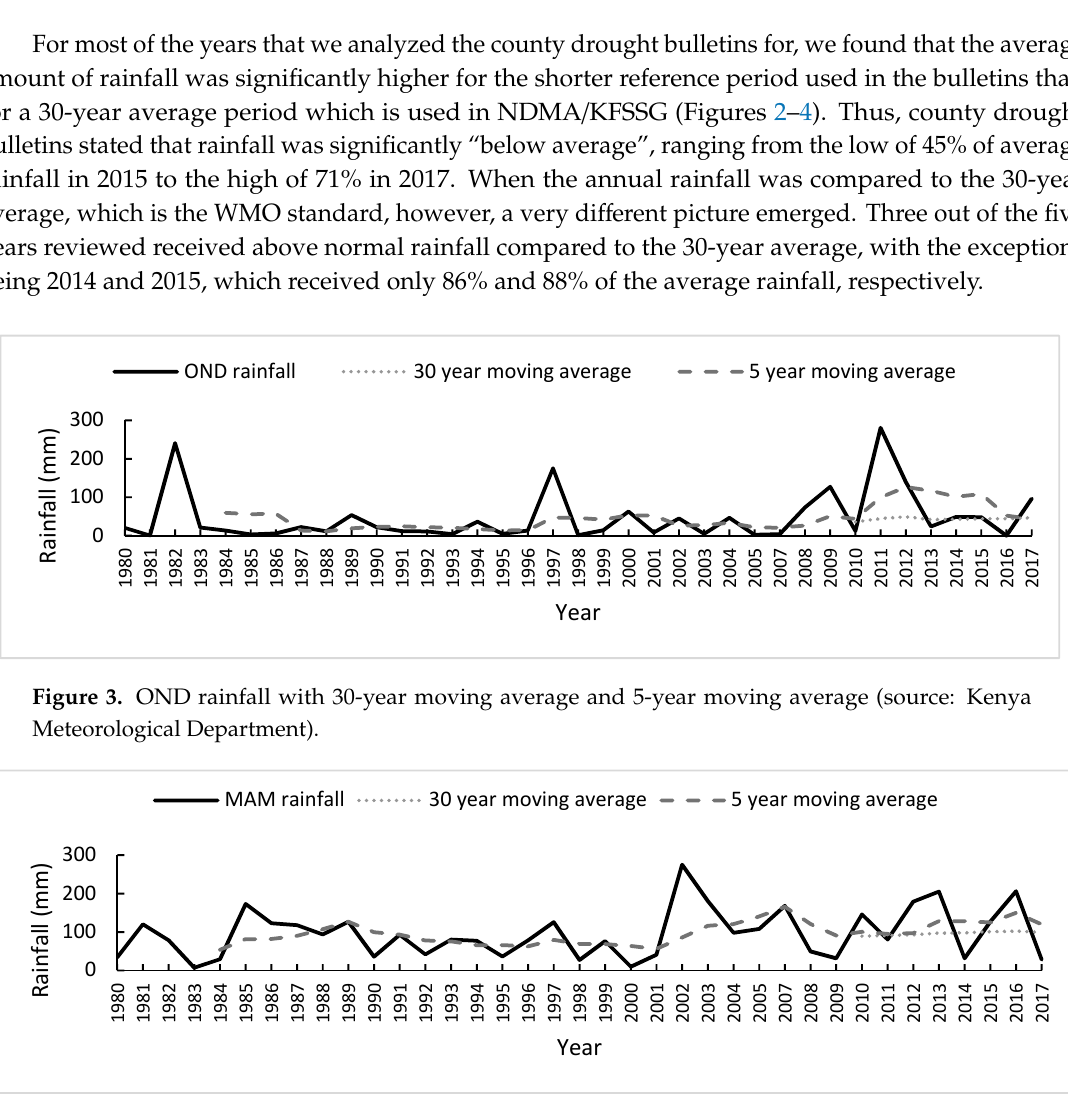
Figure 4. MAM rainfall with 30-year moving average and 5-year moving average (source: Kenya Meteorological Department).